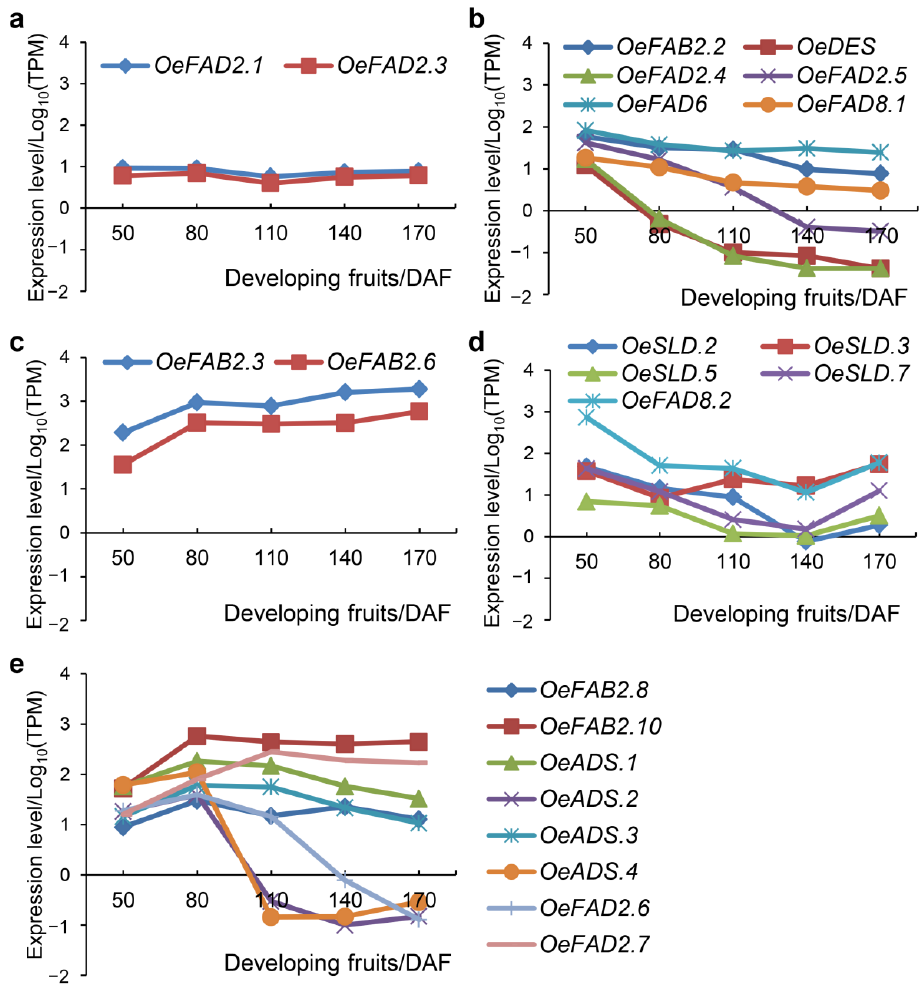
Figure 4. Fruits developing expression trends of FAD genes in olive. Transcriptome data of different tissues (PRJNA514943) were obtained from NCBI and included 50, 80, 110, 140, 170 DAF of olive fruits development stages. The log 10 (TPM) was calculated as the expression level. DAF, days after fertilization; TPM, Transcripts Per Million. Five expression patterns of FAD genes in developing olive fruits were shown including the genes had a relatively constant ( a ), continuous declining ( b ), continuous increasing ( c ) expression trend, and the genes with the expression levels decreased in the initial stage and then increased in the later stage ( d ) or increased in the initial stage and decreased in the later stage ( e